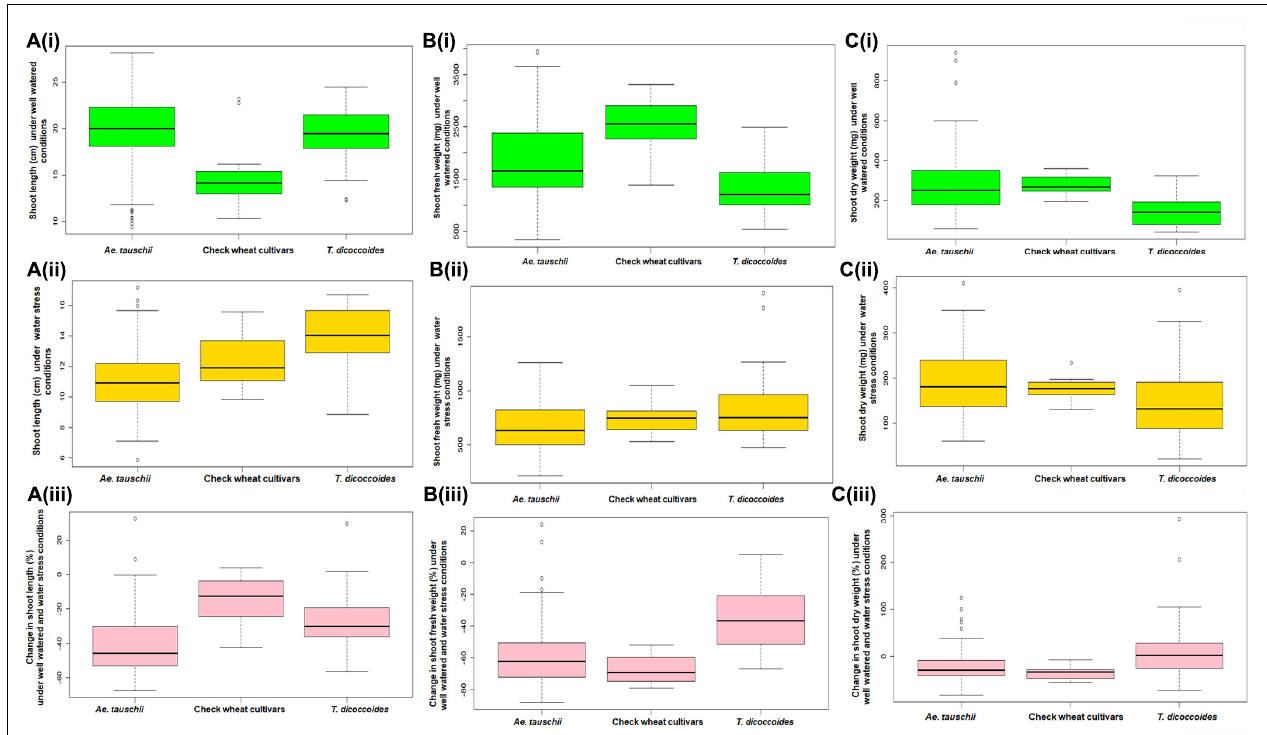
FIGURE 4 | Boxplot representation of shoot traits of accessions of Ae. tauschii , T. dicoccoides and check wheat cultivars under well watered and water stress conditions. (A) Shoot length under (Ai) well watered, (Aii) water stress, and (Aiii) change in shoot length under well watered and water stress conditions. (B) Shoot fresh weight under (Bi) well watered, (Bii) water stress, and (Biii) change in shoot fresh weight under well watered and water stress conditions. (C) Shoot dry weight under (Ci) well watered, (Cii) water stress, and (Ciii) change in shoot dry weight under well watered and water stress